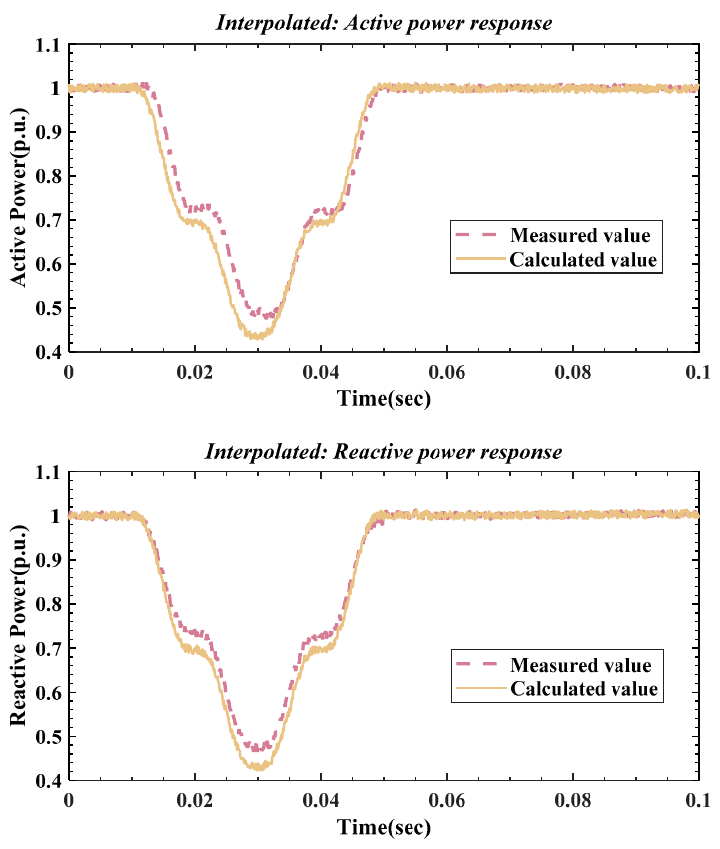
Figure 10. Interpolation fitting curve between measured data and calculated data.